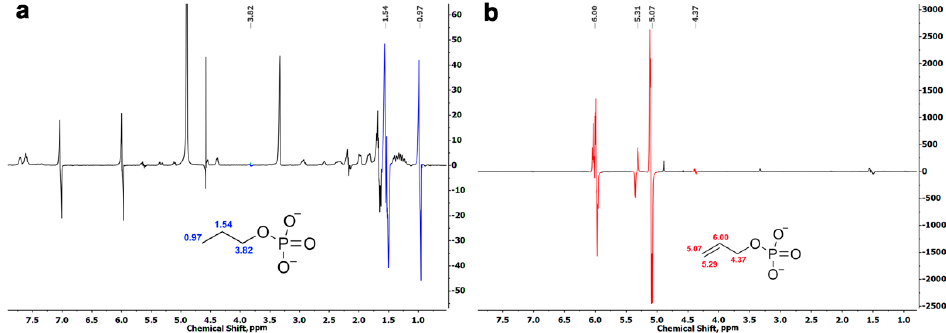
Figure 3. Shows 1 H NMR PASADENA spectra of cyclohexylamine allyl phosphate 2 ( a ) and cyclohexylamine propargyl phosphate 1 ( b ). The strong antiphase signals at 6 and 7 ppm in the spectra of cyclohexylamine allyl phosphate ( a ) belong to the known non-reactive impurities in the bubbling system.